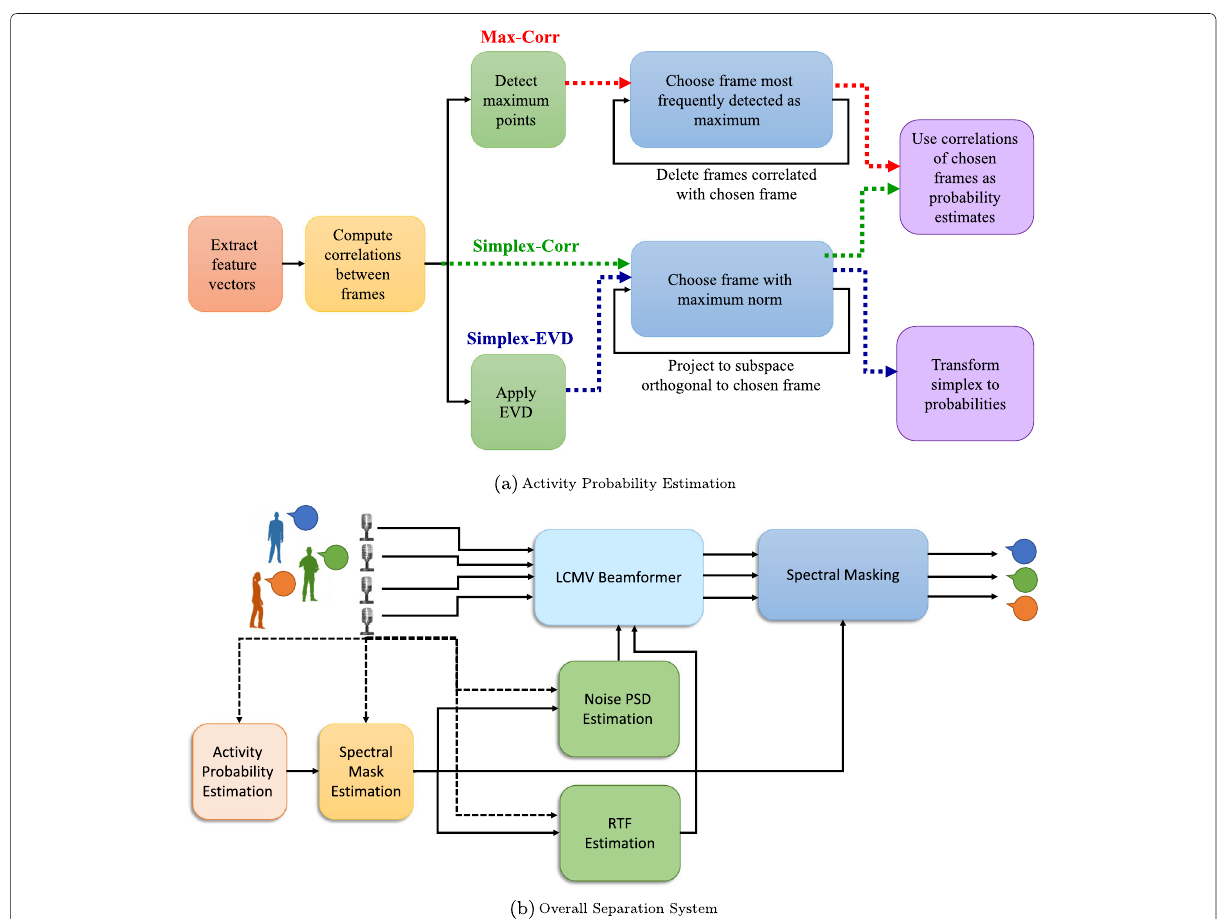
Fig. 2 Block-diagrams of a the methods for activity probability detection (“Max-Corr” derived in Section 2.2.1, “Simplex-Corr” derived in Section 2.2.2, and “Simplex-EVD” proposed in [36]) and b the overall separation